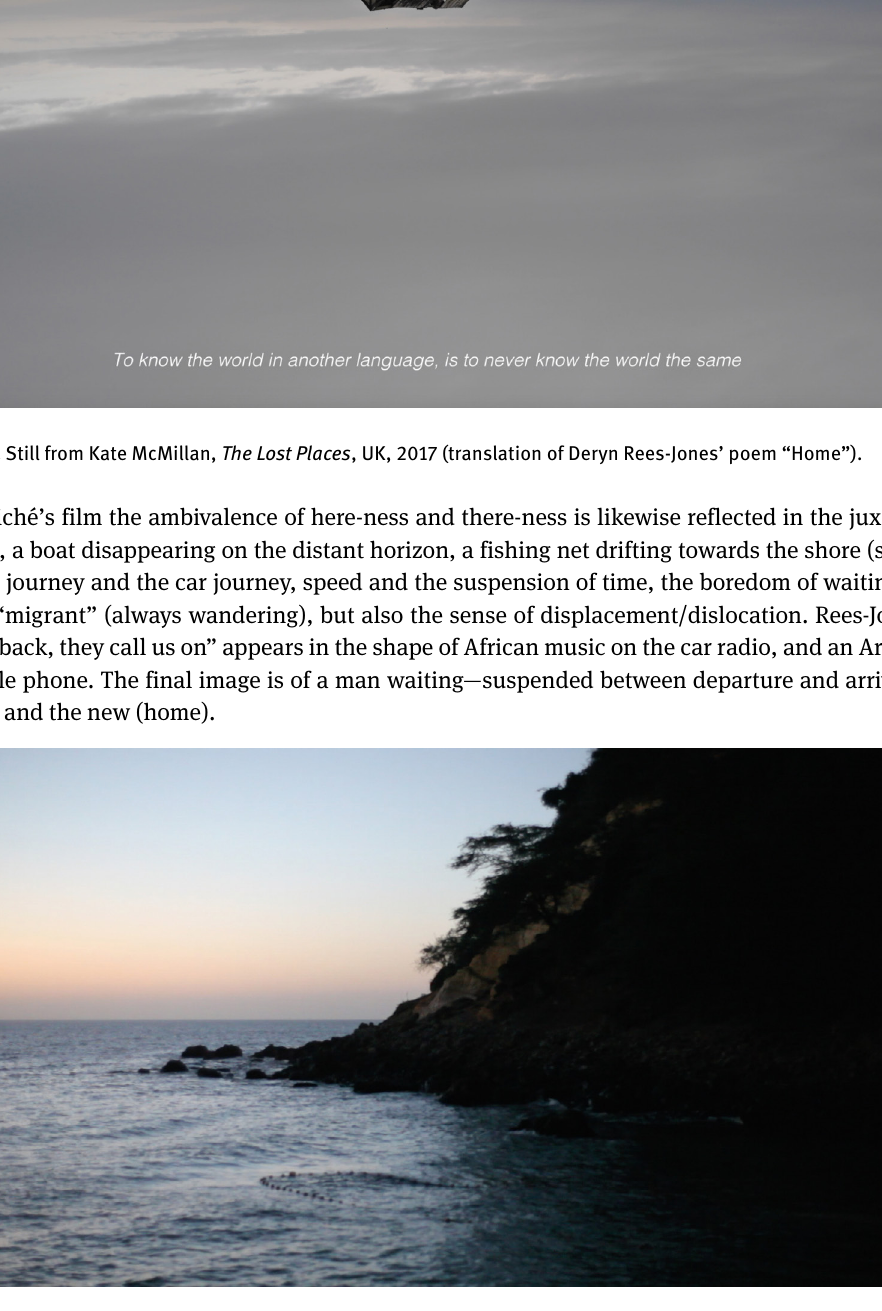
Figure 6. Still from Benoît Laffiché, Home—Chez nous , France, 2017 (translation of Elise Aru’s translation of Deryn Rees-Jones’ poem